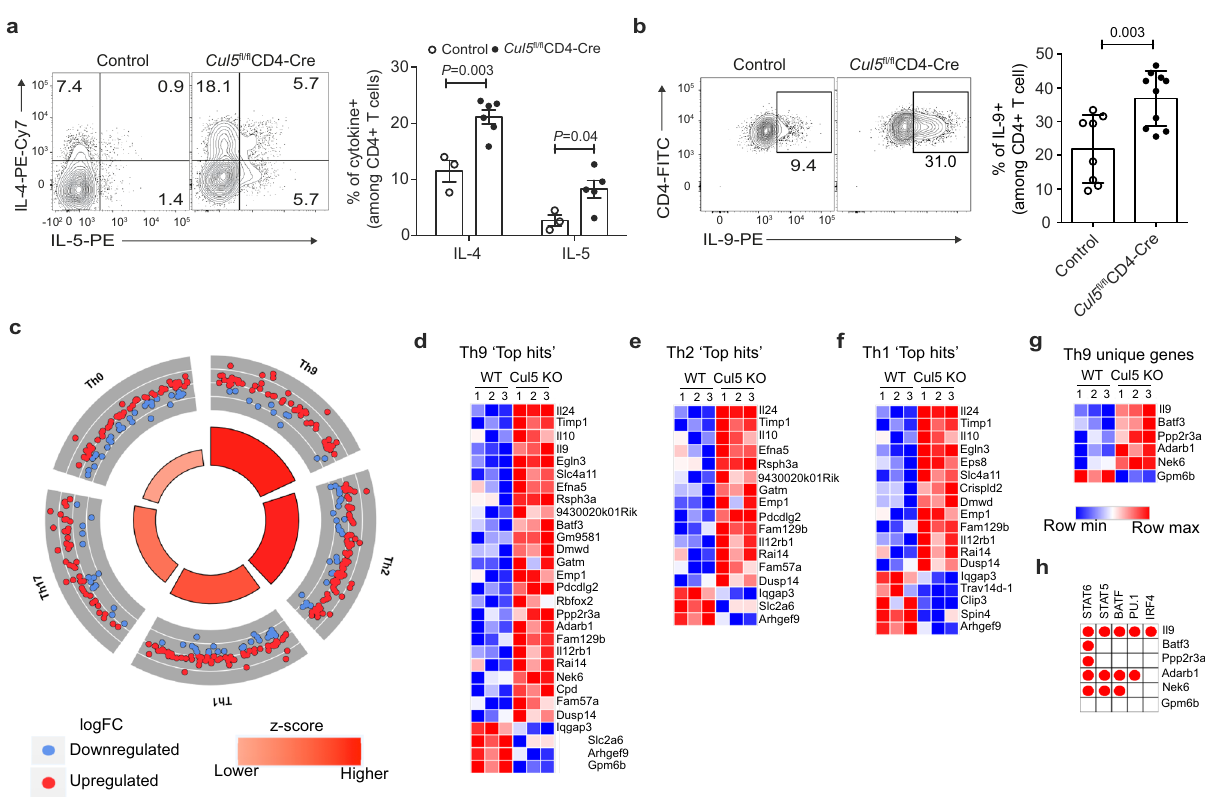
Fig. 5 Cul5-de fi cient CD4 + T cells show an increased Th9 gene signature. Naïve CD4 + T cells from 8 – 10-week-old control and Cul5 fl / fl CD4-Cre mice were isolated and cultured in Th2 and Th9 polarising conditions. a Left panel shows the representative fl ow plot for IL-4 + and IL-5 + cells under Th2 polarizing condition. The bar graph on right shows the consolidated data. For IL-4 + cells, n = 3 control, n = 6 Cul5 fl / fl CD4-Cre , for IL-5 + cells, n = 3 control, n = 5 Cul5 fl / fl CD4-Cre , examined in two independent experiments. b Left panel shows the representative fl ow plot for IL-9 + cells in control and Cul5 fl / fl CD4- Cre CD4 + T cells cultured under Th9 polarizing conditions. The bar graph on the right shows the consolidated data for n = 8 control, n = 10 Cul5 fl / fl CD-Cre, examined in four independent experiments. c – h RNASeq analysis was used to measure the transcript levels in control and Cul5 deleted CD4 + T cells cultured for 2 days in Th9 polarizing condition. n = 3 control and Cul5 fl / fl CD4-Cre CD4 + T cells examined in one experiment. c Ontological analysis of the differentially regulated genes, calculated by GOplot algorithm is shown. Circle plots depict the enrichment of genes associated with particular Th subtype. Greater the size of the inner trapezoids represents greater -log10 value (adj. p -value). Heatmap of Th subtypes. To generate heat maps, we fi rst selected genes that were enriched in different Th subtype compared to naïve CD4 T cells from publicly available dataset 39 . We selected 200 most differentially regulated genes for each subtype and classi fi ed these as top hit genes. We then compared these top hits genes to the differentially regulated genes from our RNAseq dataset and to generate heatmaps. Heatmap of top hit genes identi fi ed in Th9 ( d ), Th2 ( e ), and Th1 ( f ) subtypes that were also differentially regulated in WT and Cul5 de fi cient CD4 + T cells. g Heatmap of top hit genes which were identi fi ed exclusively in Th9 subtype. h The red circle in the table indicates the binding sites for the respective transcription factors present in the particular gene. Data is presented as Mean ±SEM in panels a , b . p- value was calculated using unpaired two tailed t- test. Source data are provided as a Source Data fi (Fig. 6h, lanes 3 and 5). Furthermore, in both cases the intensity of band corresponding to pJak1 was lower in NAEi treated cells (Fig. 6h, Lane 4 and 6), supporting that pJak1 was less ubiquitylated when Cul5 activity is inhibited. These results supported that CIS and Cul5 regulate the ubiquitination and degradation of pJak1.